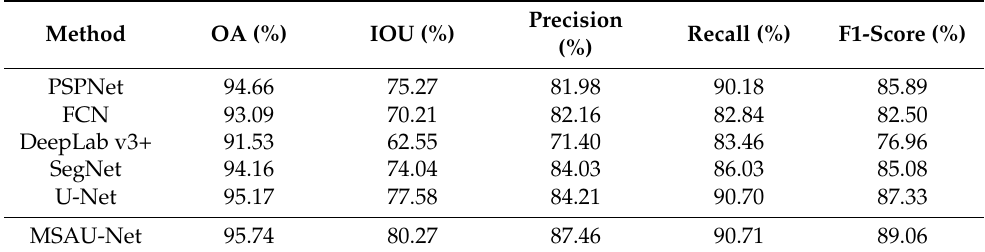
Table 2. Experimental results of the GF-7 self-annotated building segmentation dataset.